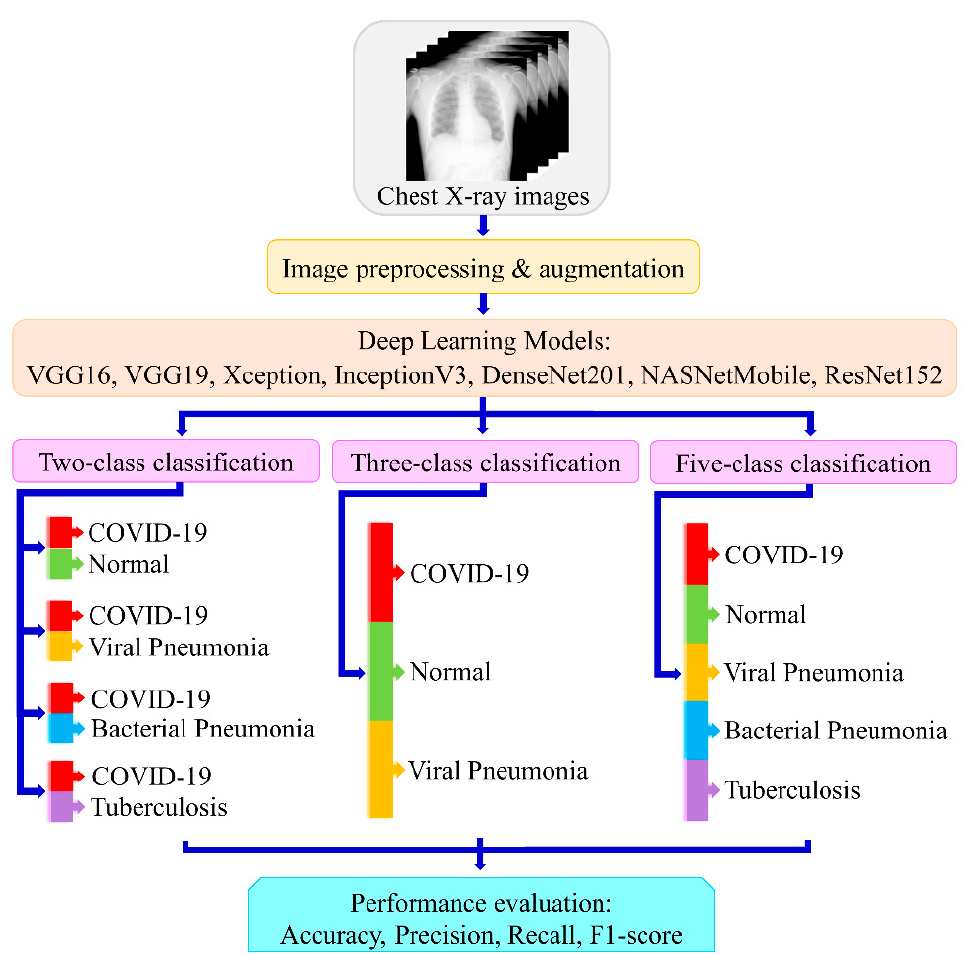
Figure 1. Overall schematic diagram of the proposed method for multiclass scenario using seven deep learning models.